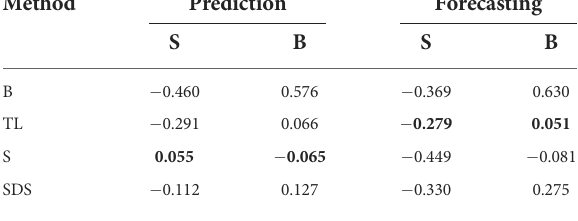
TABLE 4 Sex-Fairness-(S)core and Sex-Fairness-(B)ias of the different methods for PHQ-2 prediction and forecasting: (B)aseline-GRU without personalisation, (T)ransfer (L)earning, (S)ubgroup models, and (S)ubject-(D)ependent (S)tandardisation. Method Prediction Forecasting